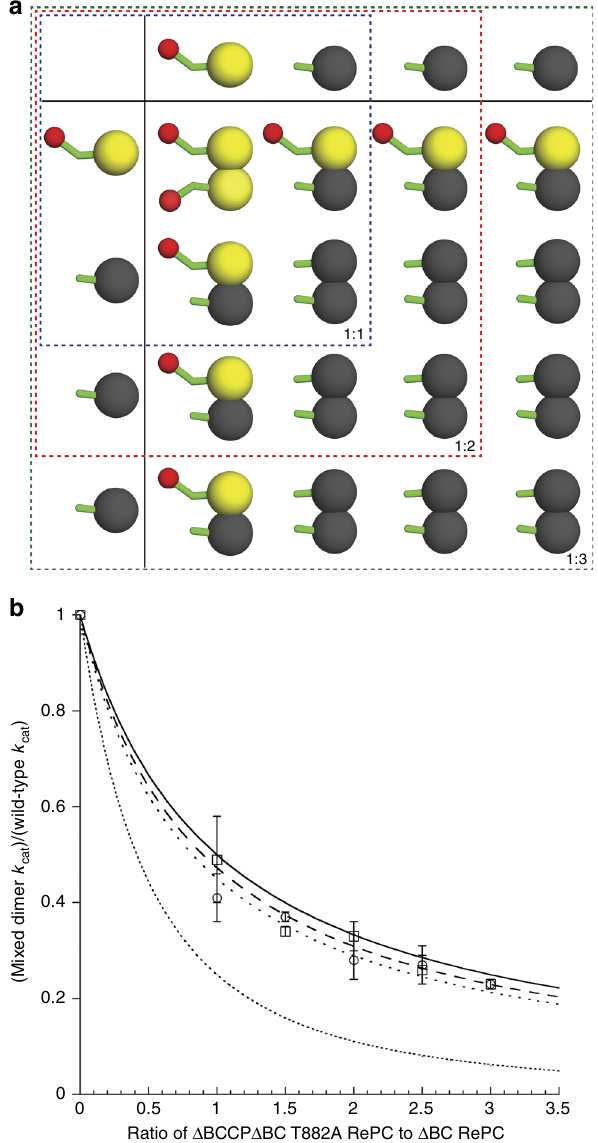
Fig. 3 Intramolecular BCCP translocation. To assess intramolecular translocation, WT Δ BC RePC was diluted with increasing molar ratios of inactive Δ BC Δ BCCP T882A RePC. a The predicted population of homodimers and heterodimers at different ratios of mixing WT Δ BC RePC with Δ BC Δ BCCCP T882A RePC. b Two theoretical curves are predicted, depending on whether the residual activity of the mixed tetramers results 100% (solid line; Eq. (1)) or 0% (dotted line; Eq. (2)) from an intramolecular translocation of the BCCP domain. The experimental data, in the presence (dashed line, open squares) and absence (dotted line, open circles) of acetyl CoA was fi t to an interpolation of these two equations (Eq. (3)) revealing ~80% intramolecular translocation of BCCP both in the presence and absence of acetyl CoA. Each data point represents the average of three independent measurements from one mixed